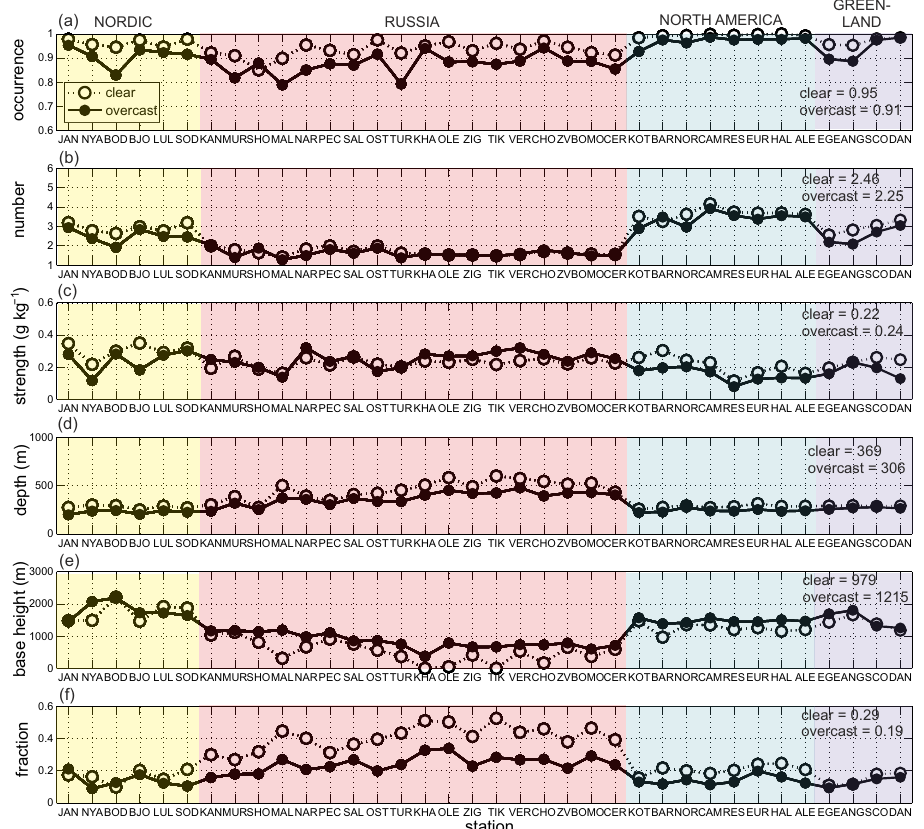
Fig. 5. (a) Occurrence of humidity inversions, (b) mean number of humidity inversions in a single profile, (c) median strength, (d) median depth and (e) median base height of humidity inversions, and (f) the fraction of surface-based humidity inversions in clear-sky and overcast conditions. Averages over all the Arctic stations are given (on the right) for clear-sky and overcast conditions